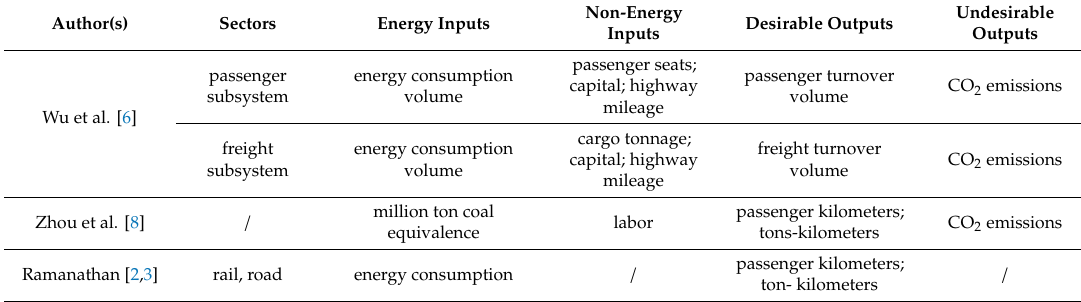
Table 1. Inputs and outputs in transport EEE